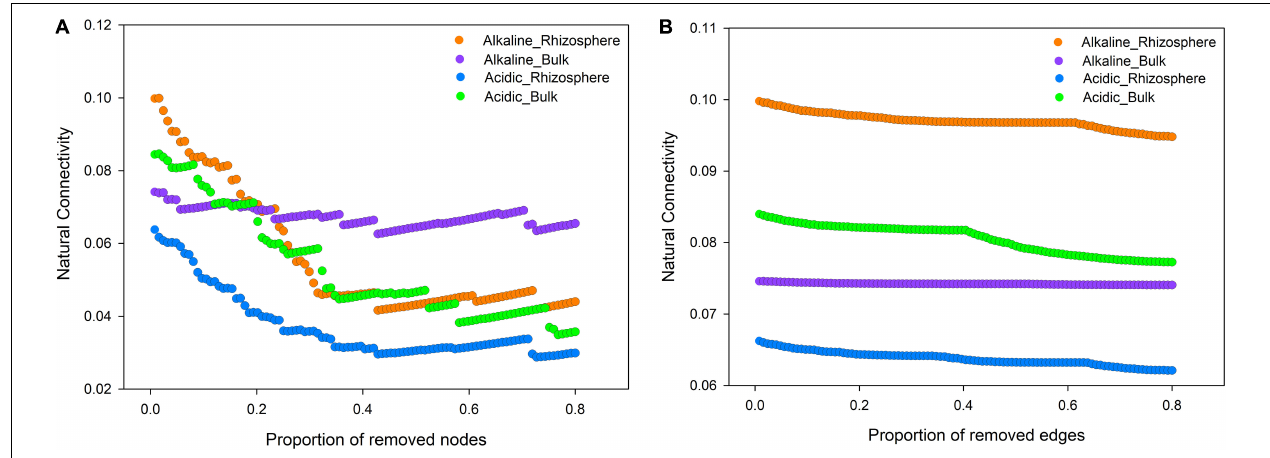
FIGURE 6 | Robustness analysis of the rhizosphere and bulk soil microeukaryotic community networks in acidic and alkaline soils. Robustness is depicted as the relationship between natural connectivity and the proportion of excluded (A) nodes and (B)